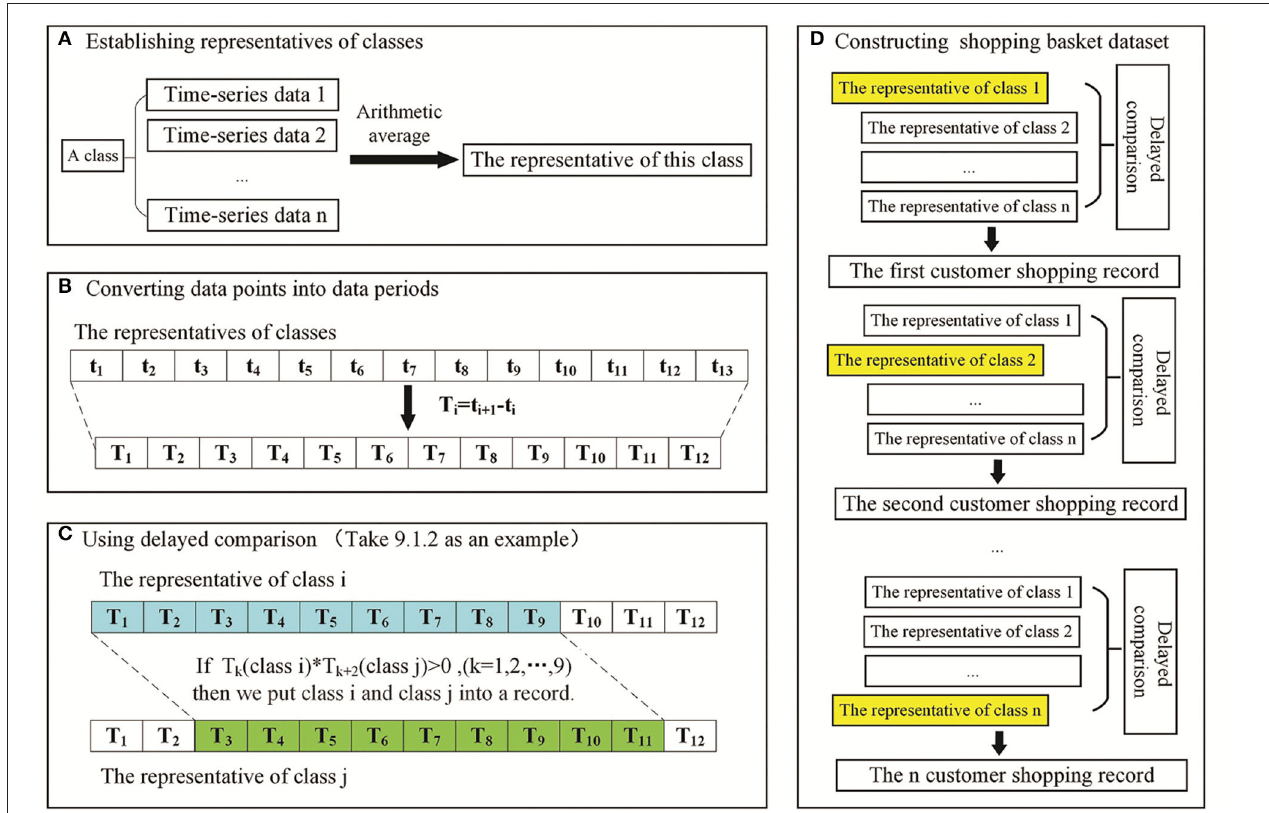
FIGURE 1 | Schematic of delayed comparison to build the shopping basket dataset. (A) Representative establishment of a cluster. (B) Data points were subtracted to convert data points into time periods. (C) Delayed comparison for addressing the lags between functional alterations and their corresponding changes in protein synthesis/PTMs. (D) Construction of the shopping basket dataset for the Apriori